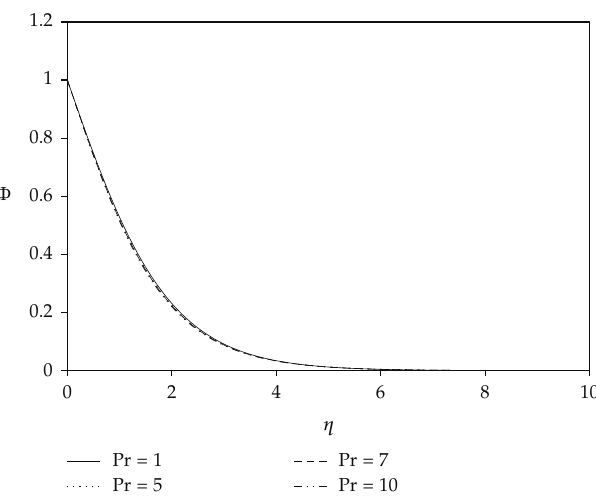
Figure 14: Concentration profile for di ff erent values of Pr for Du (cid:8) 0 . 03, Sr (cid:8) 2, θ r (cid:8) 5, Le (cid:8) 0 . 1, N (cid:8) 1, and Sc (cid:8) 0 . 1.